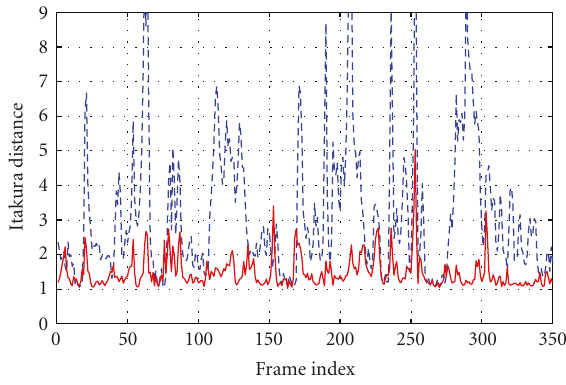
Figure 6: Itakura distance between the NM and TM spectra (dashed lines), and the NM and estimated spectra (solid lines) for a speech